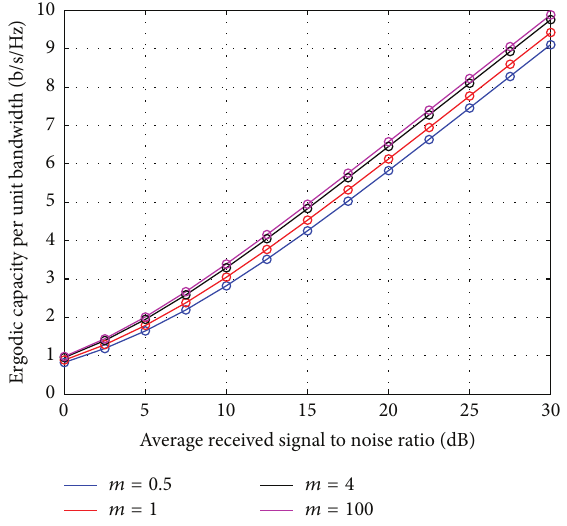
Figure 2: Influence of shadowing 𝑚 -parameter on the mean capacity values when the dominant component is more powerful than the scattered waves ( 𝜅 = 5 ). The value of 𝜇 -parameter is set to 3 in all curves. The marks correspond to results obtained by numerical simulation.